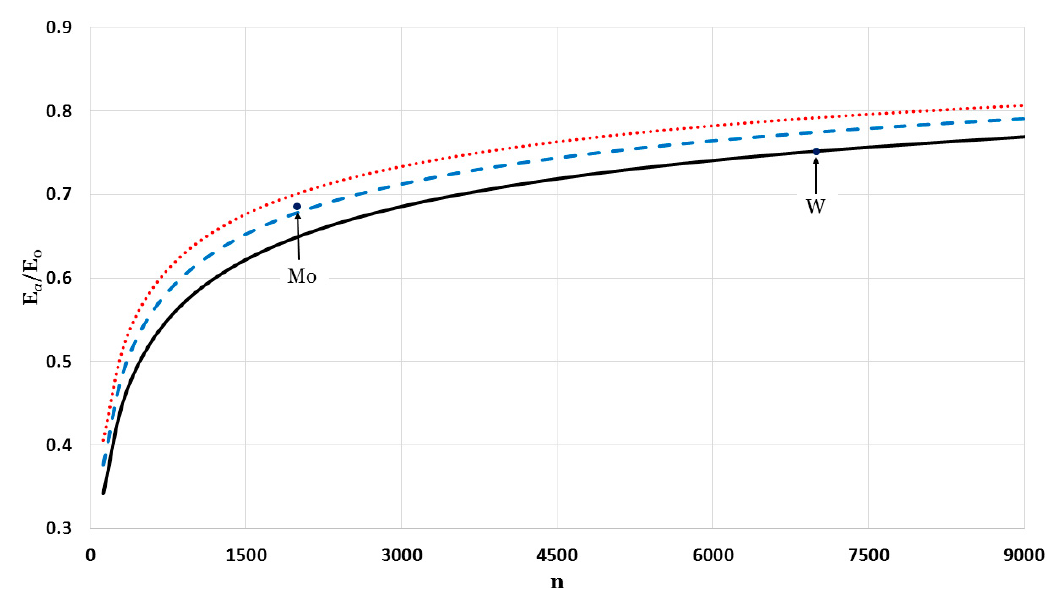
Figure 7. The variation of the relative cohesive energy of nanoparticles in a face-centered cubic structure as function of the number of atoms for (cid:1865) = 2 and different values of (cid:2009) : 2.3 (black solid line), 2.4 (blue dashed line), and 2.4 (red dotted line). The experimental values [23,24] are denoted by dark blue circles.